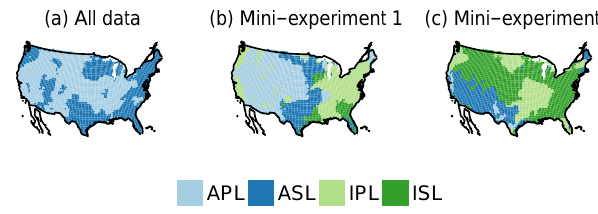
Figure 5. Model preference at each location based on AIC statis- tics. The coloring indicates which model is preferred for (a) all data, (b) mini-experiment 1 data, and (c) mini-experiment 2